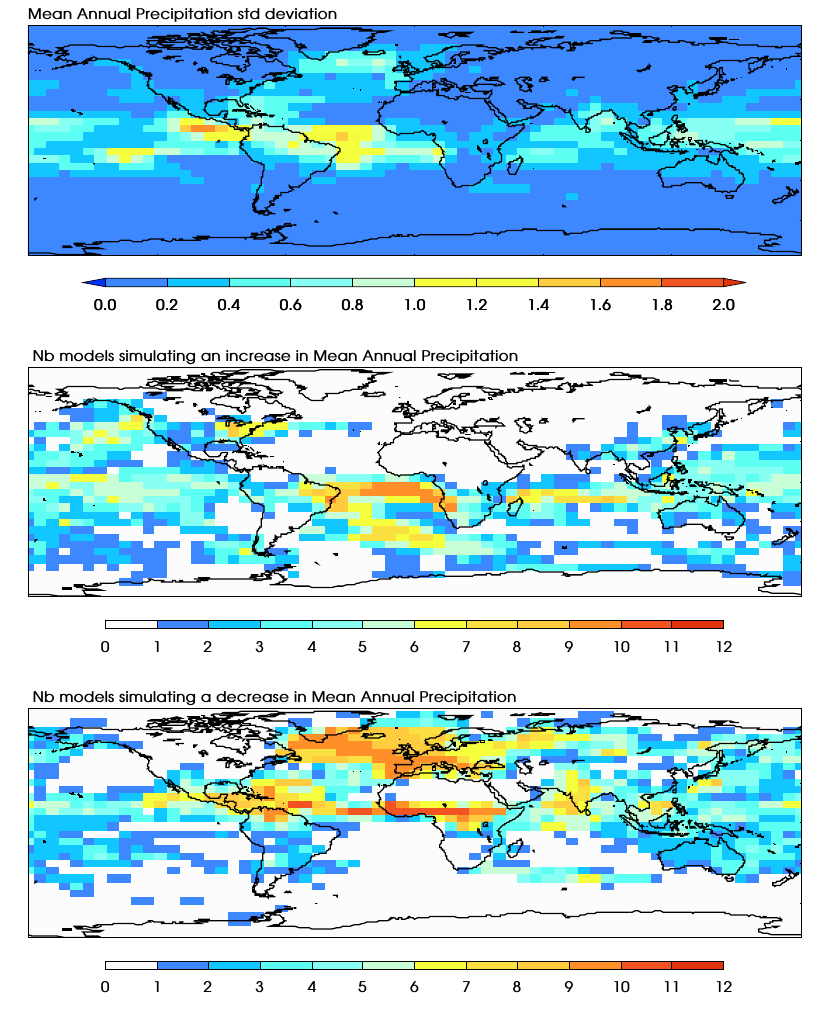
Fig. 5. Same as Fig. 3 for the mean annual precipitation (in mmday − 1 for the top